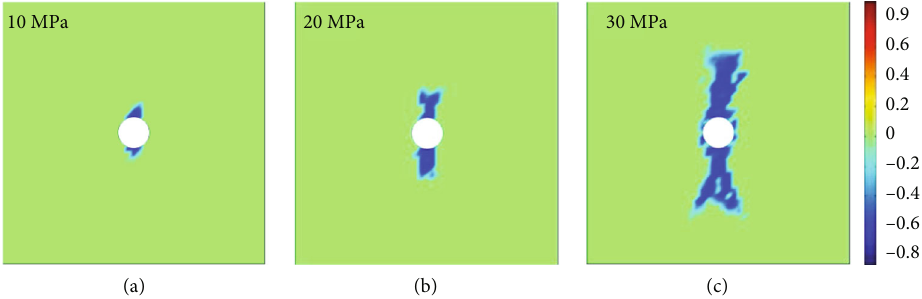
Figure 6: The rock damage conditions at the last step. (a) 10MPa. (b) 20MPa. (c)